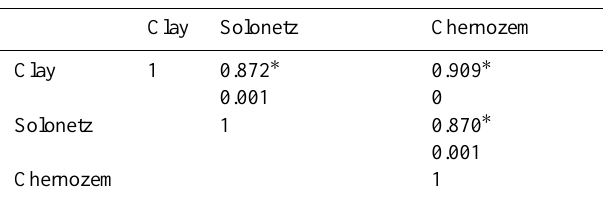
Table 3. Pearson-r correlation matrix for the Hurst exponent of three studied